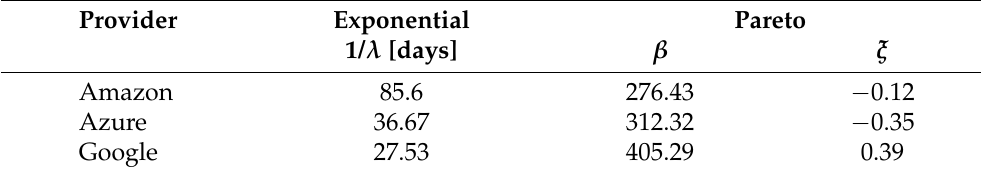
Table 2. Parameters in the Poisson–Pareto model.